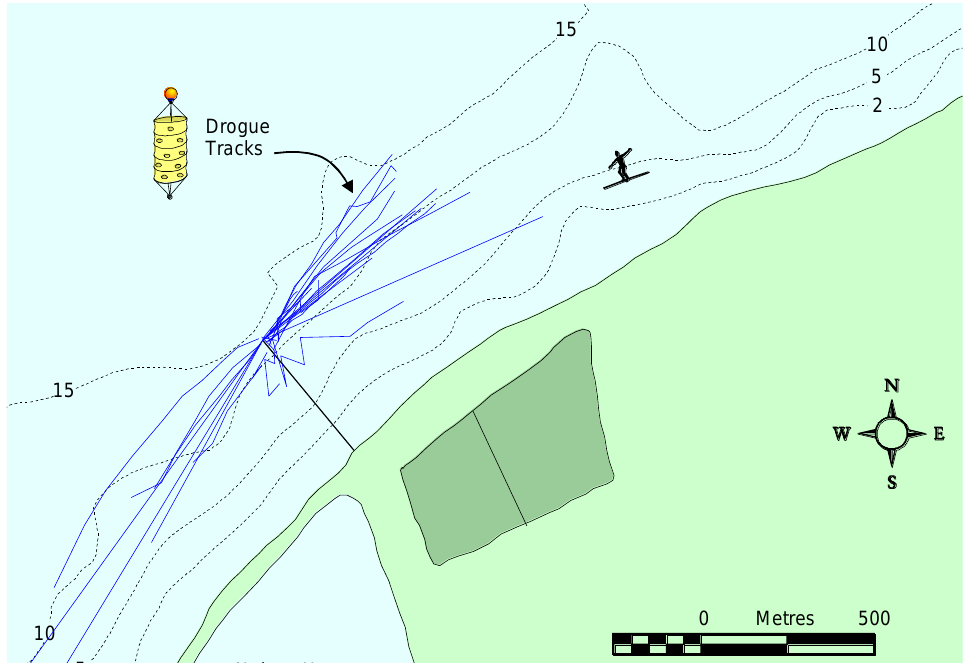
Figure 6. Summary of the drogue tracks. The recreational area surf break is represented by the black symbol ≈8 0 m NE of the outfall.